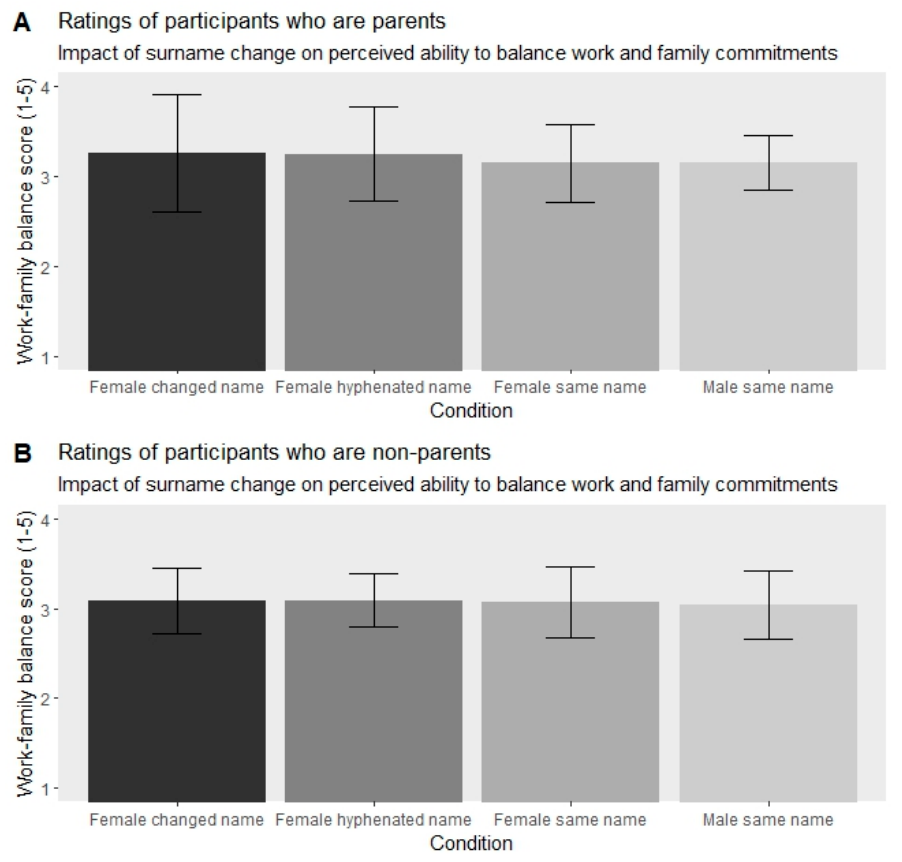
Figure 3. Work–family balance scores varied depending on participant parental status. Participants who are parents gave higher work–family balance scores on average than participants who were nonparents.